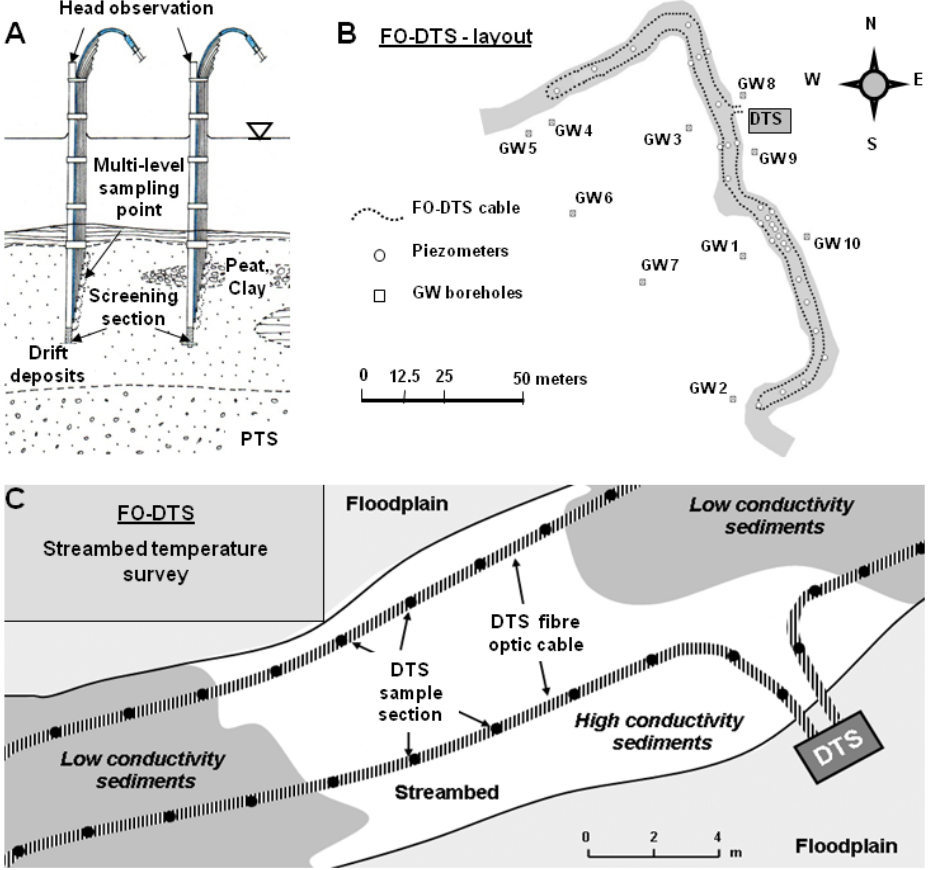
Fig. 3. Experimental installations at the River Tern with (A) : streambed piezometer setup for VHG monitoring, PTS=Permo-Triassic Sand- stone.; (B) : FO-DTS cable loop in the investigated meander bend; (C) : close-up of cable layout in the streambed sediment with measurement intervals indicated by the DTS sample sections. (The outline of the low-conductivity sediments is